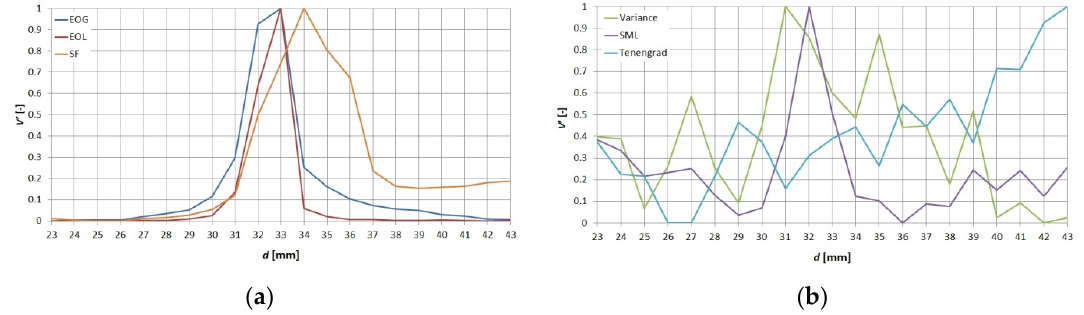
Figure 4. Relationship V’ = f( d = const) for the third series of thermograms: ( a ) sharpness measures: EOL, SF, EOG; ( b ) sharpness measures: variance, SML, Tenengrad.